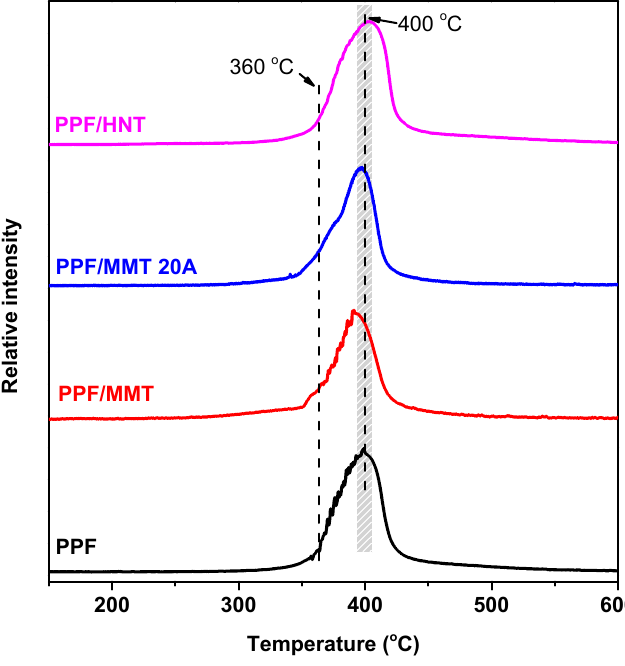
Figure 10. EGA pyrograms of PPF and its nanocomposites.